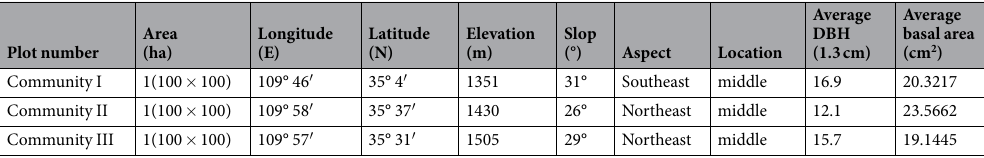
Table 1. Basic information of the permanent